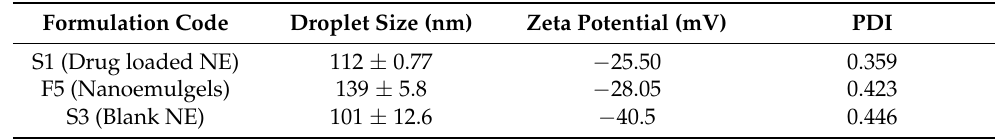
Table 6. Particle size, zeta potential, and PDI of S1, F5, and S2.